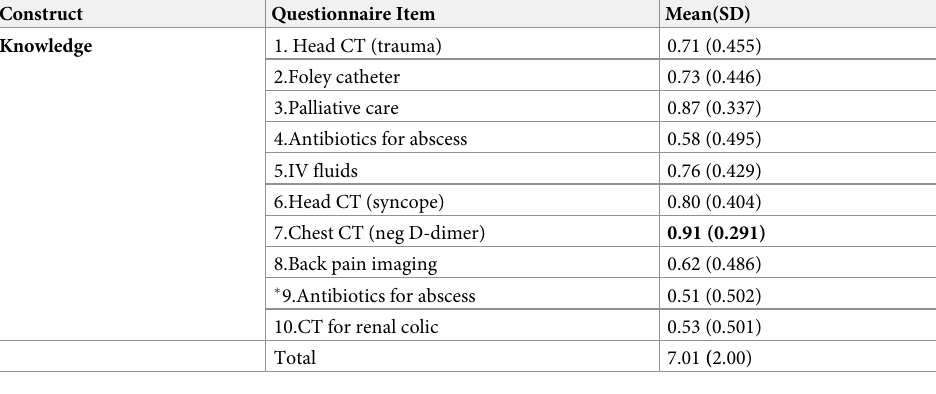
Table 2. Knowledge of unnecessary care among emergency physicians regarding Choosing Wisely